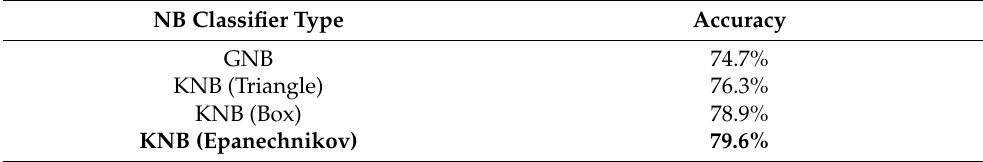
Table 2. The NB classifier accuracy for different conditional